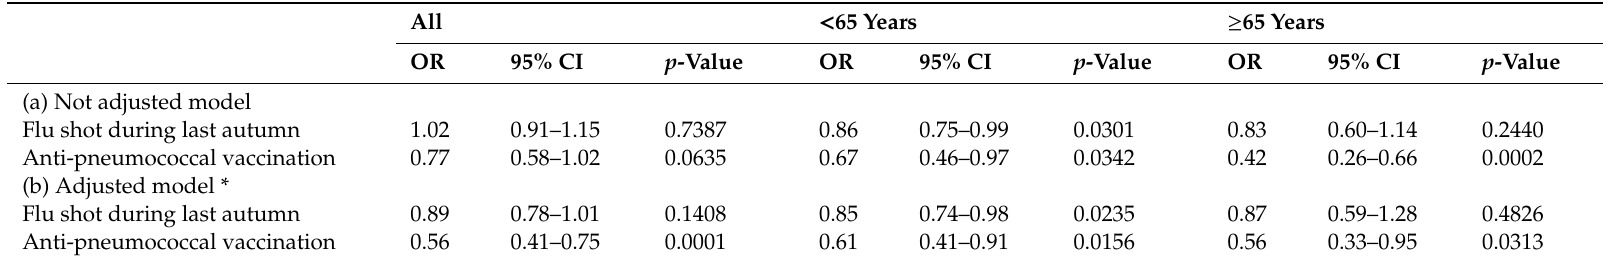
Table 3. Characteristics of study participants associated with SARS-CoV-2 swab positive results (vs. negative